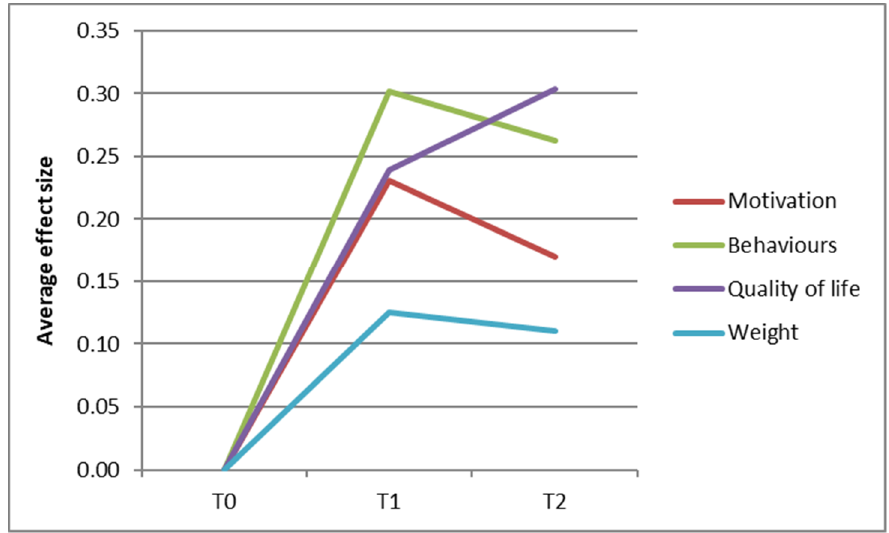
Figure 1. Overall changes among the adults regarding motivation, behaviours, quality of life and weight.